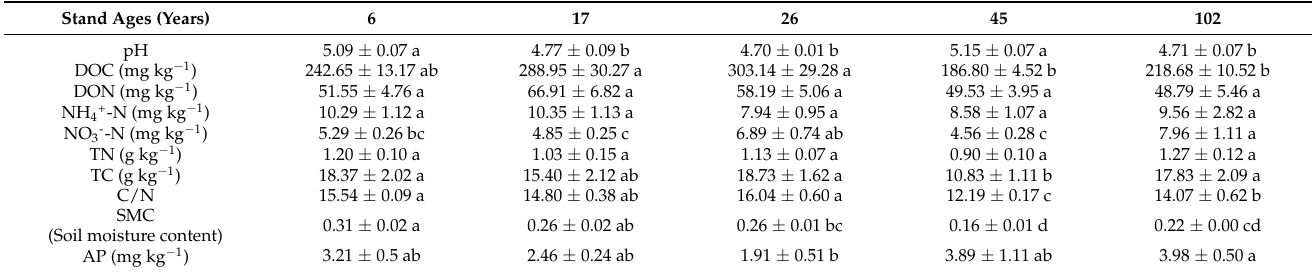
Table 1. Rhizosphere soil nutrient concentrations in different stand ages of Chinese fir plantations in subtropical China.